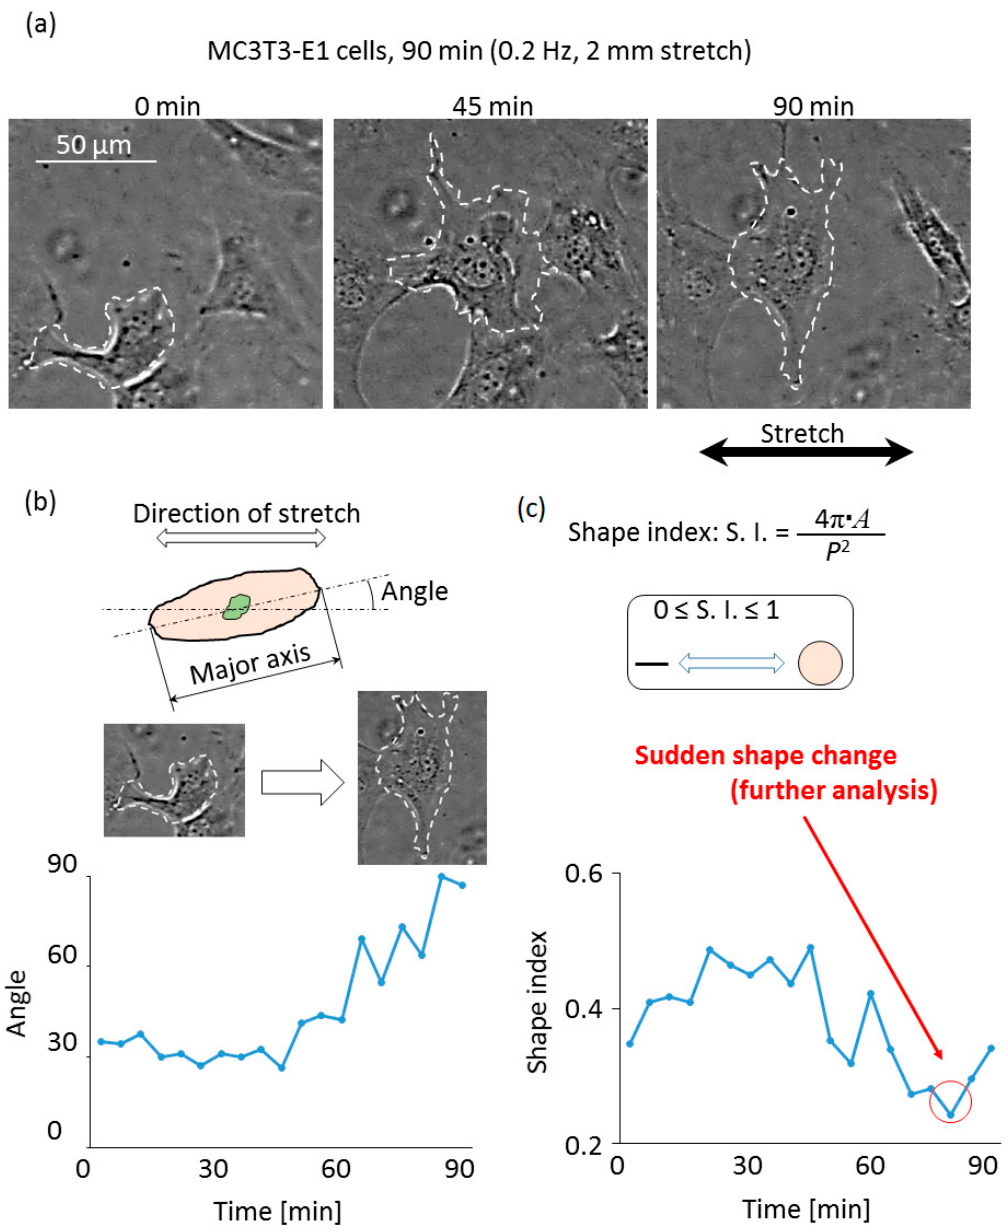
Figure 11. Cell morphological response after cyclic stretch exposure using the developed system. Images were captured from a real-time movie. ( a ) The cell enclosed by the dashed line was selected as the target, and images at the beginning, middle, and end of experiments are shown here. ( b ) The orientation of the cell with respect to the stretching direction. Analysis results of images with an interval of 5 min. ( c ) Cell shape change with a time solution of 5